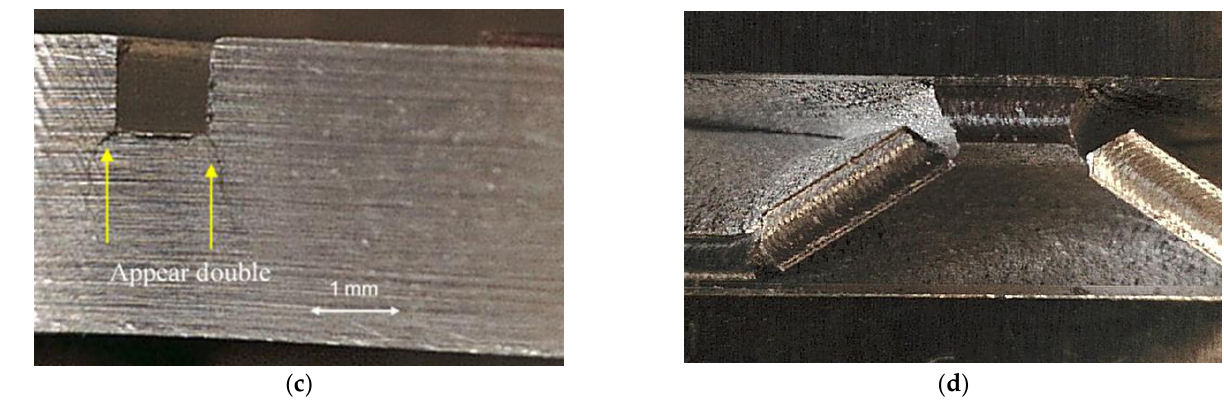
Figure 31. Double crack appearance in pre-seeded 1 mm crack depth. ( a ) Top view, ( b ) bottom view, ( c ) side view, ( d ) final Figure 31. Doublecrackappearanceinpre-seeded1mmcrackdepth. ( a )Topview, ( b )bottomview, ( c )sideview, ( d breaking.